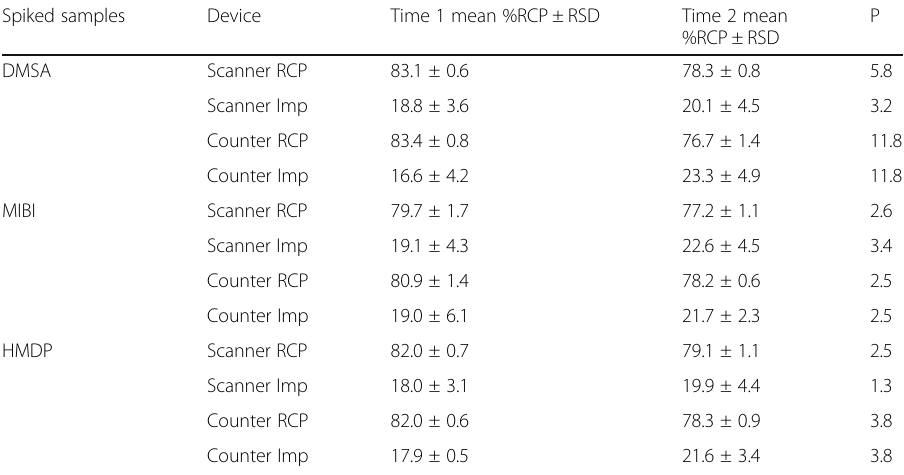
Table 4 Intermediate Precision results: Effect of Time (acceptance criteria ANOVA P ≥ 0.05) Spiked